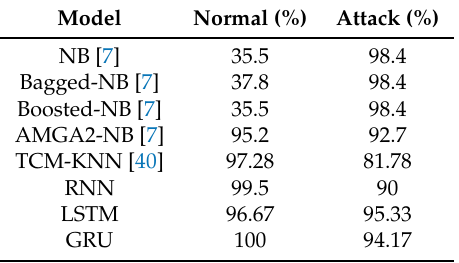
Table 7. Comparison accuracy detection of attack types results on ISCX